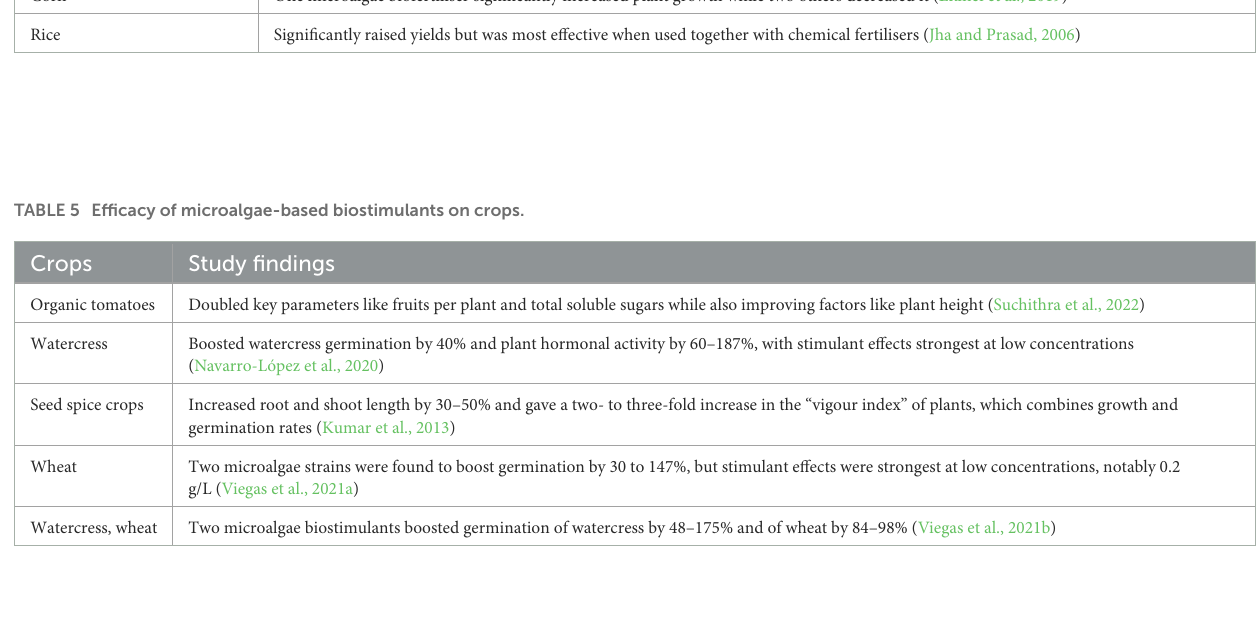
TABLE 6 Examples of studies that explored aspects of these technologies pertinent to climate resilience. Threat Study findings Drought, heat,